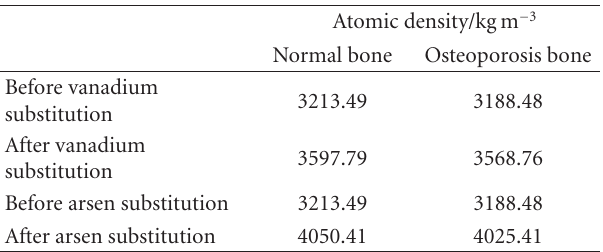
Table 5: Atomic density in hydroxyapatite of osteoporosis and normal bone.